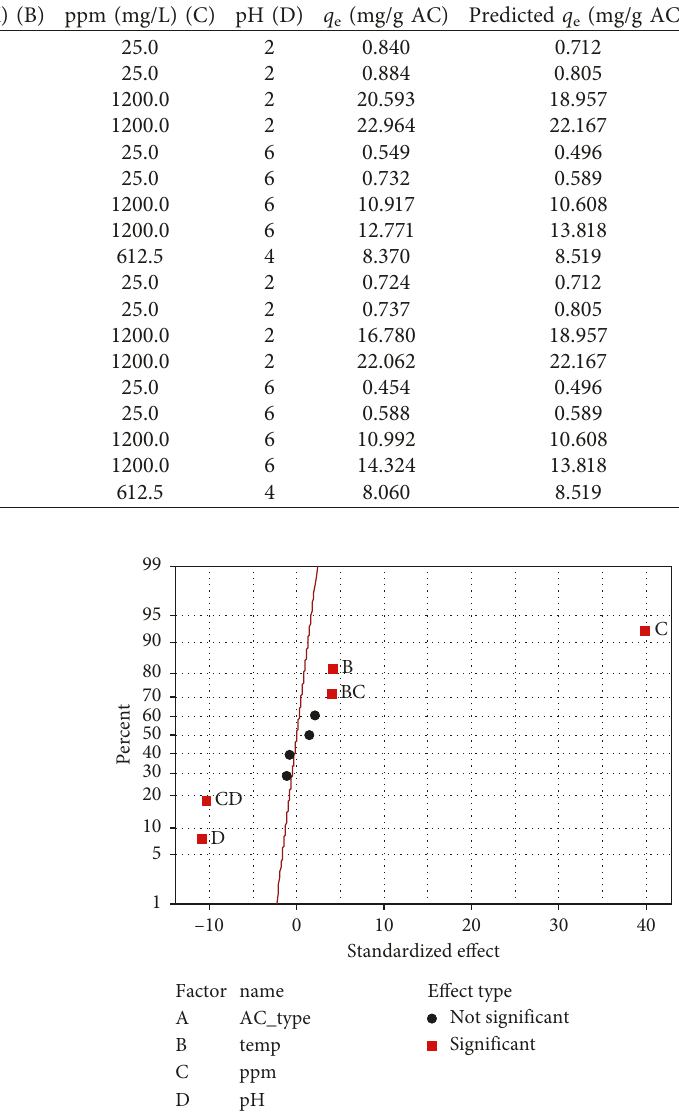
Table 3: Experimental runs and their results and predicted values from the regression analysis.